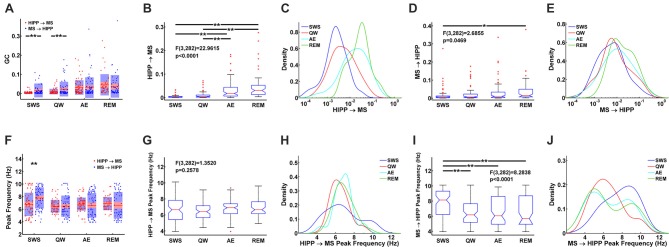
Statistical comparison of HIPP→MS and MS→HIPP GC. (A) Average and distribution of HIPP→MS and MS→HIPP GC for each state. (B–E) GC based on GC direction during SWS, QW, AE, and REM sleep. Comparison of HIPP→MS (B) and its density (C) vs. MS→HIPP (D) and its density (E). (F) Peak frequencies of HIPP→MS and MS→HIPP GC for each state. (G–J) Comparison of peak frequency (G) and the density of HIPP→MS (H) vs. peak frequency of MS→HIPP (average (I) and density (J)). Significance indicators “*” and “**” represents p < 0.05 and p < 0.005, respectively.